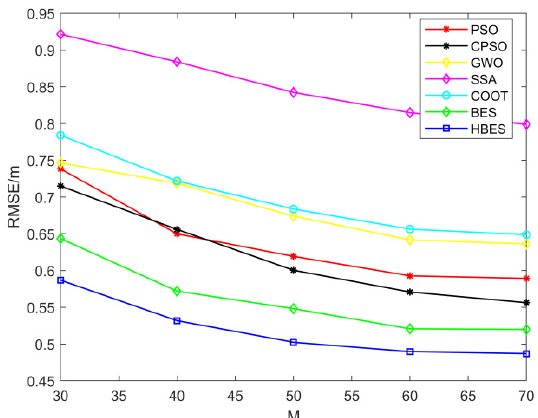
Figure 6. Relationship between RMSE and population size.